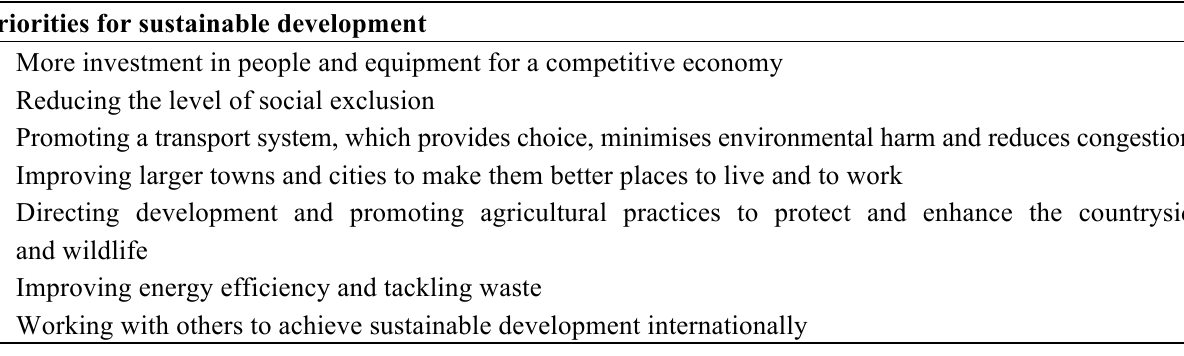
Table 1. Priorities for sustainable development in England